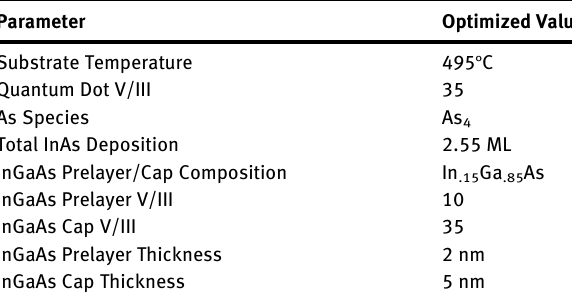
Table  : Summary of optimized quantum dot (QD) growth condi- tions for InAs quantum dots-in-a-well grown by molecular beam epitaxy. ML stands for monolayer (hereafter